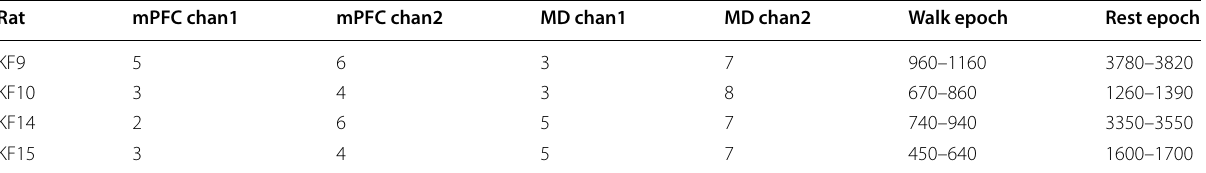
Table 2 Guide to determine the best channels and epochs to use of baseline walk and rest recordings in medial prefrontal cortex (mPFC) and the mediodorsal (MD) thalamus, as mentioned in the file named “Coherence Phase Plot Guide”. Column 1 denotes animal id, columns 2 and 3 shows two good channels of the mPFC recordings and coumns 4 and 5 of the MD recordings. Finally, columns 6 and 7 show the range of artefact free epochs during walking and at resting, respectively